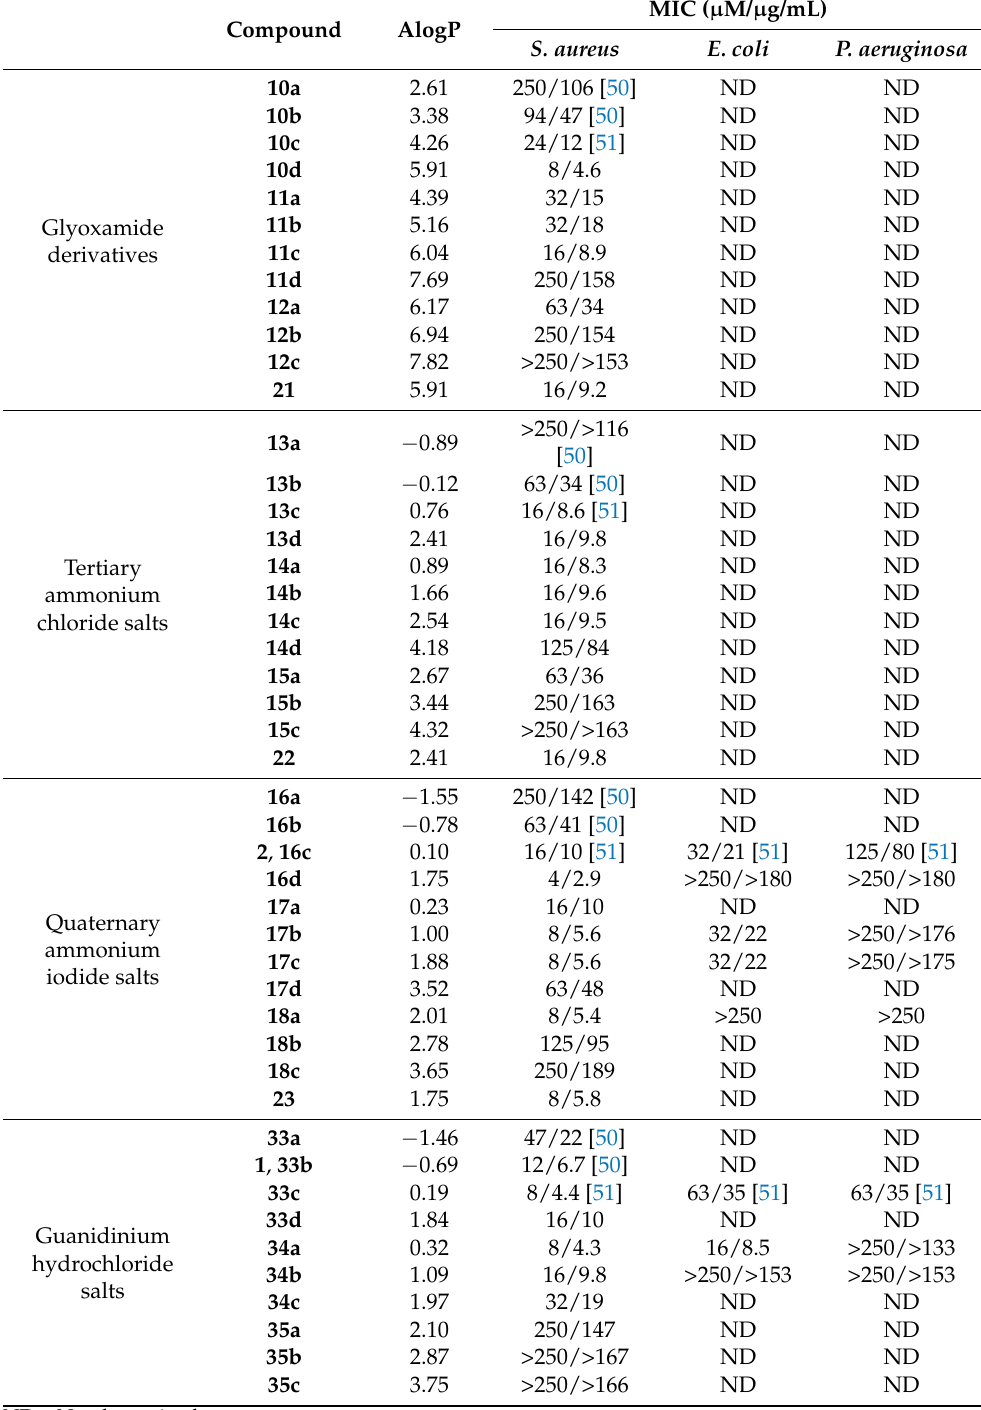
Table 1. Minimum inhibitory concentration (MIC) of peptidomimetics against S. aureus , E. coli and P. aeruginosa and the calculated AlogP values of